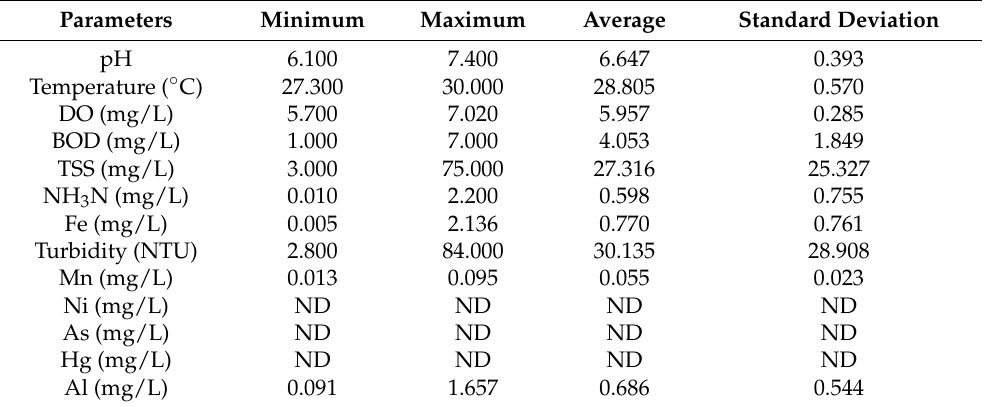
Table 1. Summary of the data obtained from in-situ and laboratory measurements. ND is not detected. Parameters Minimum